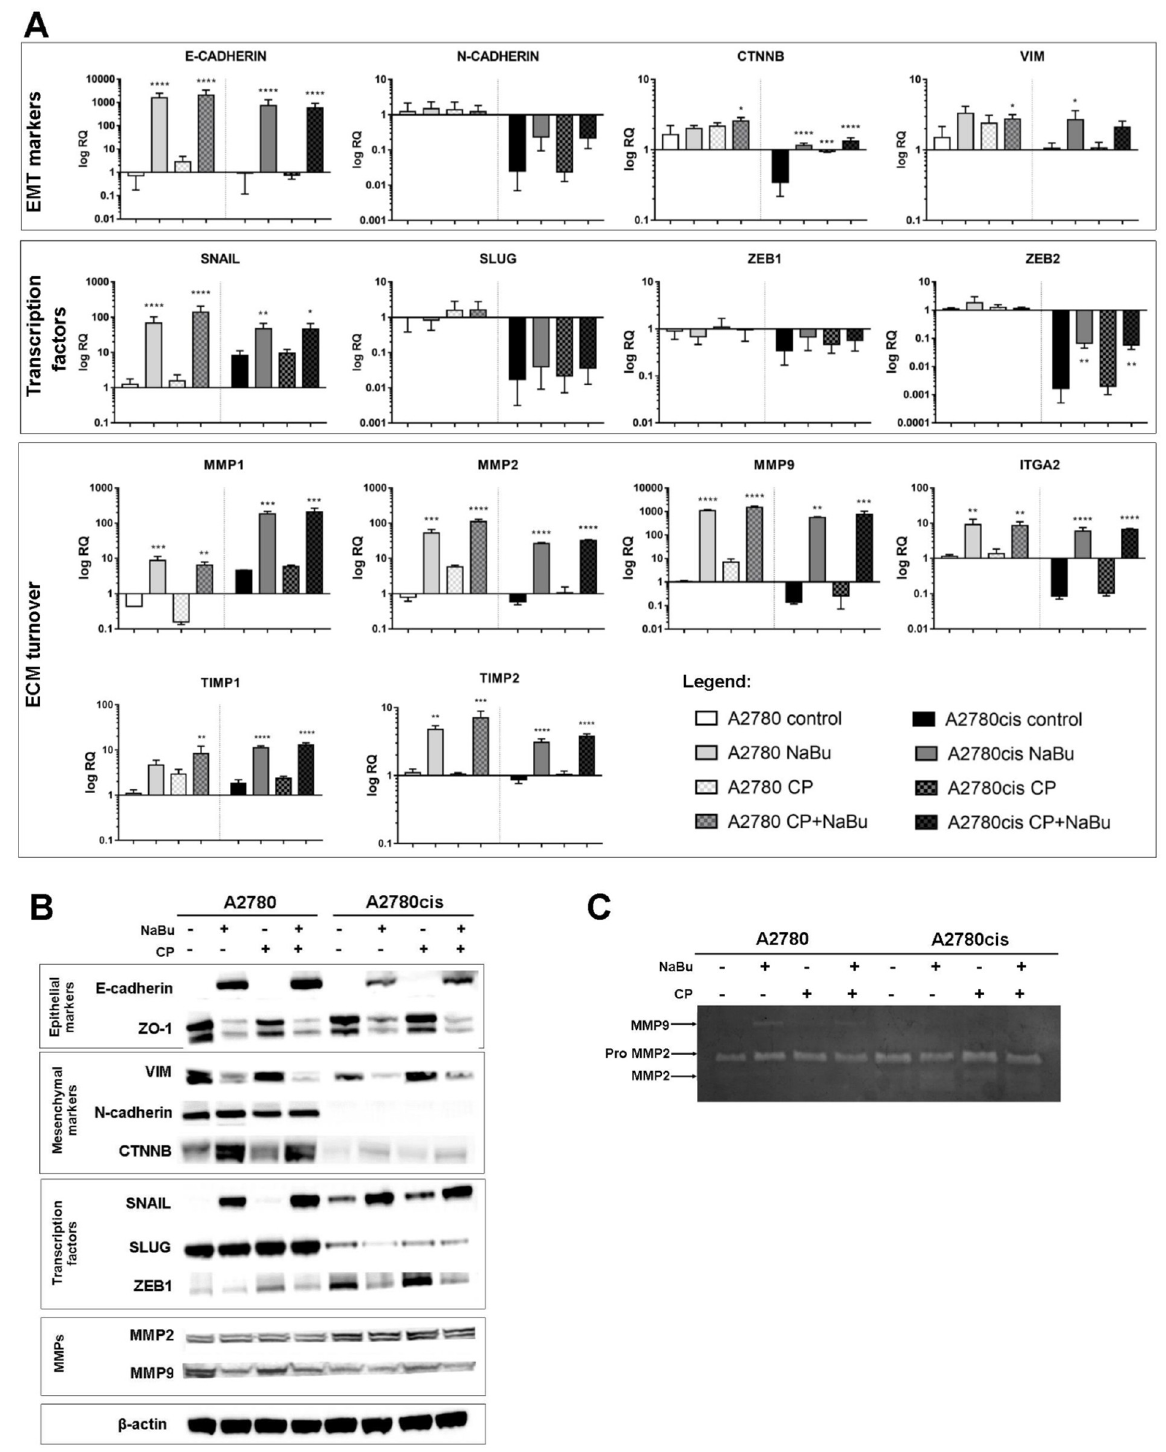
Fig 3. EMT related genes and proteins expression. Gene expression of EMT related genes in A2780 and A2780cis cells was measured using qPCR (A). Results were normalized for the HPRT expression. Data are presented as means ± SD of 3 independent experiments. Significance was tested using one-way ANOVA ( � P � 0.05, �� P � 0.01, ��� P � 0.001, ���� P � 0.0001 vs. control). Protein expression was detected by immunoblot analysis (B). A representative immunoblot of at least three independent experiments is presented. β -Actin was used as a loading control. Activities of MMP-2 and MMP-9 in the cell culture supernatants were measured by gelatin zymography. Gelatinolytic activity of pro and active MMP-2 and active MMP-9 are visible as a clear area on the gel (C).